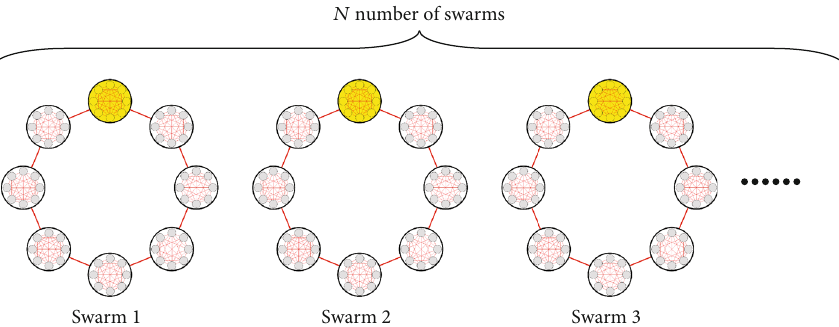
Figure 10: Multi-swarm PSO topologies. Each swarm is divided into sub-swarms. The particles within a sub-swarm have a global topology, and a ring topology is used between